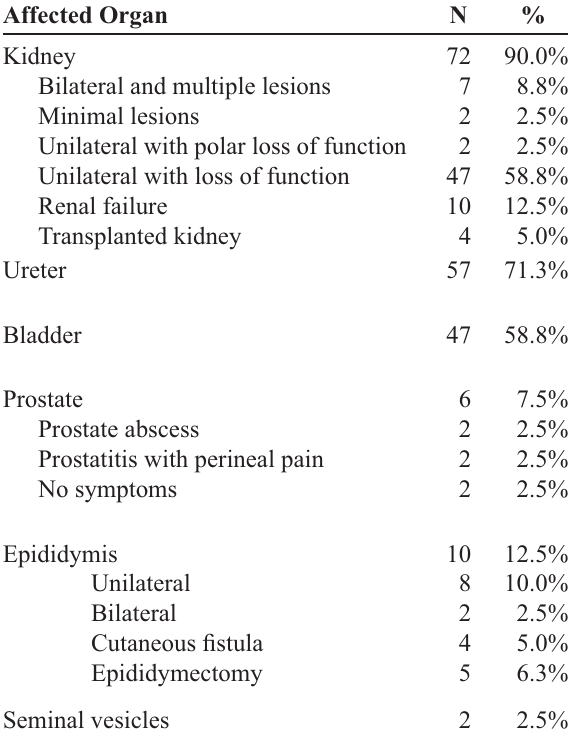
Table 2 – Description of the affected